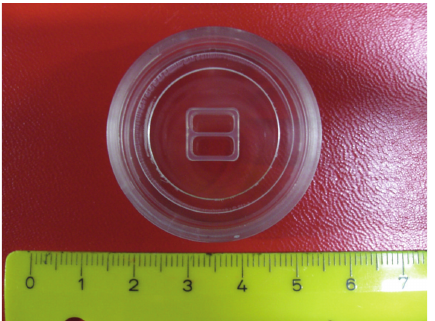
Figure1:Culture-insertina24-wellformatdishtoproduceuniform scratches in parallel samples.